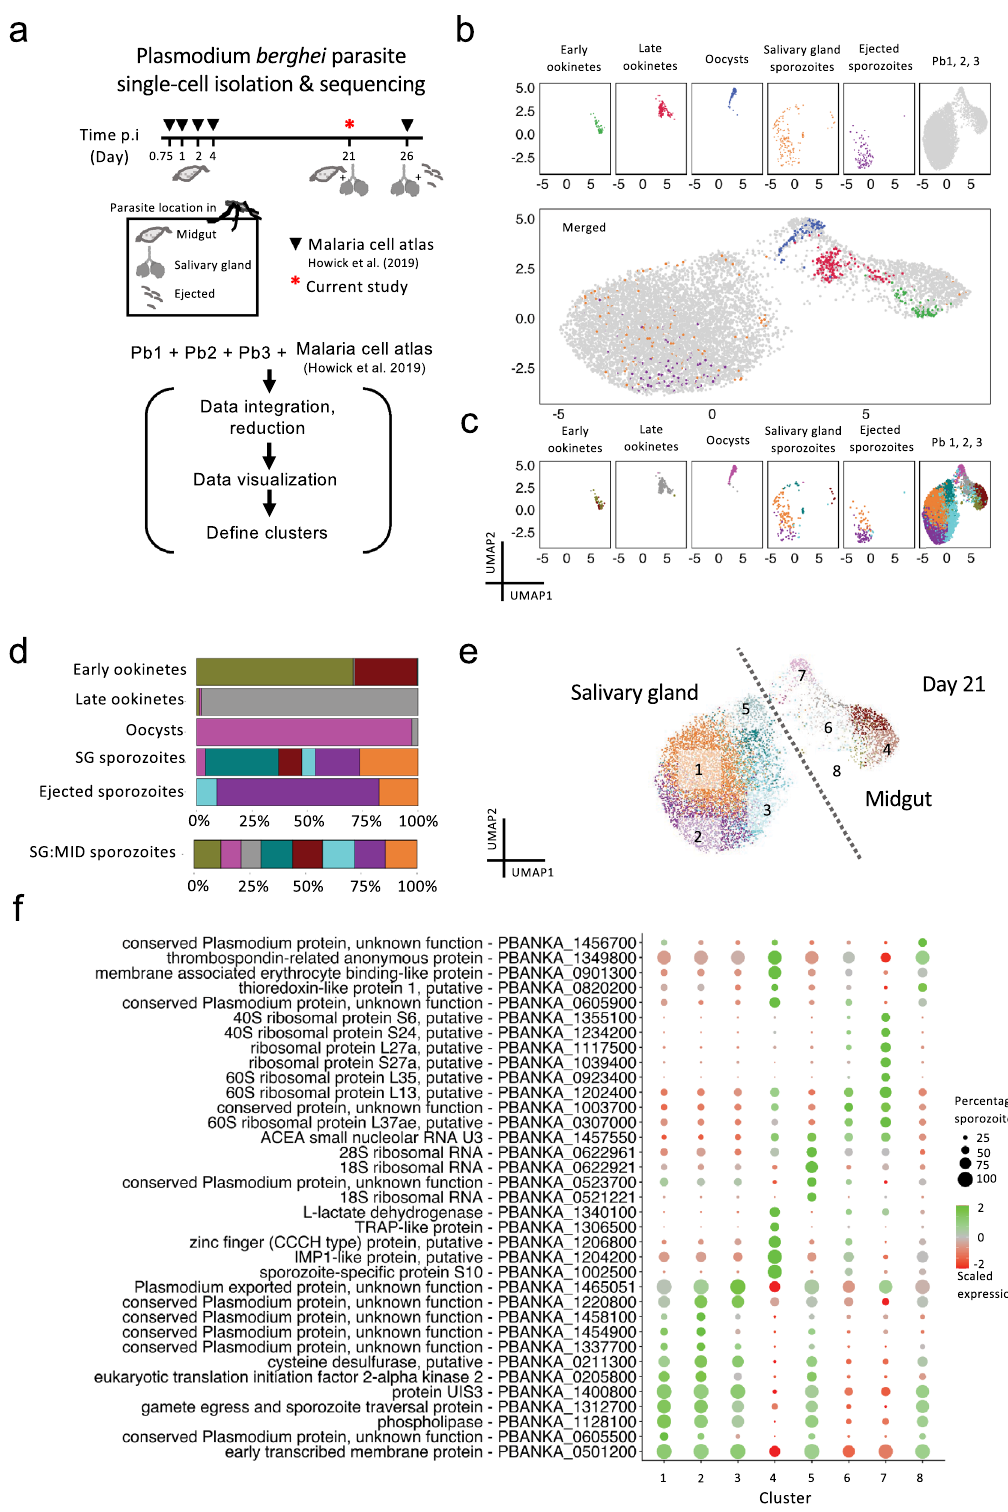
Figure 3. Redefining sporozoite populations using the Malaria Cell Atlas as a reference. ( a ) Sampling time points of P. berghei ANKA parasites at single-cell resolution during its development in the mosquito (top) and schematic illustrating the workflow used to redefine the clustering resolution for the mixed MID and SG sporozoite scRNA-seq data (bottom). ( b ) UMAP representations displaying integrated datasets colored by parasite life-stage individually (top) and overlaid (bottom). ( c ) UMAP representation displaying integrated datasets by cluster. ( d ) Distribution of parasites in each cluster across its different developmental stages. ( e ) UMAP representation displaying the redefined clustering of MID and SG sporozoites isolated on day 21 post mosquito infection. Dashed diagonal line represents the predicted break between SG and MID sporozoites. Algorithm used to cluster: Leiden, resolution = 0.7. ( f ) Dot plot illustrating top sporozoite markers in each of the clusters predicted to be composed of sporozoites derived from SGs and MIDs. All plotted genes have adjusted P value < 0.05; statistical significance was assessed by using Wilcoxon rank-sum test. See Supplementary Table S4 online for the complete